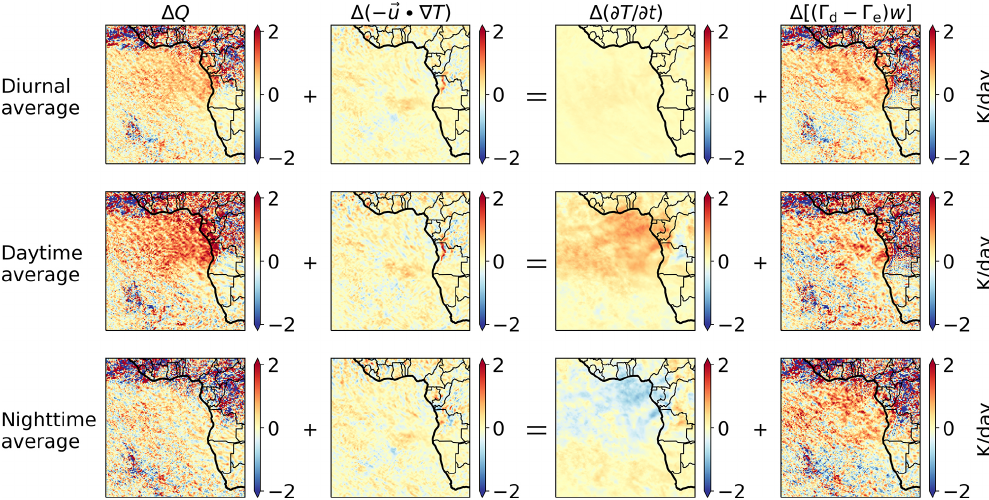
Figure 11. Decomposition of terms of the first law of thermodynamics averaged between 2 and 5km and over the full 14–20 August 2017 period. FireOn–RadOff differences in diabatic heating (first column), temperature advection (second column), temperature tendency (third column), and the product between stability and vertical velocity (last column) for diurnal average (top row), daytime only (middle row), and nighttime only (bottom